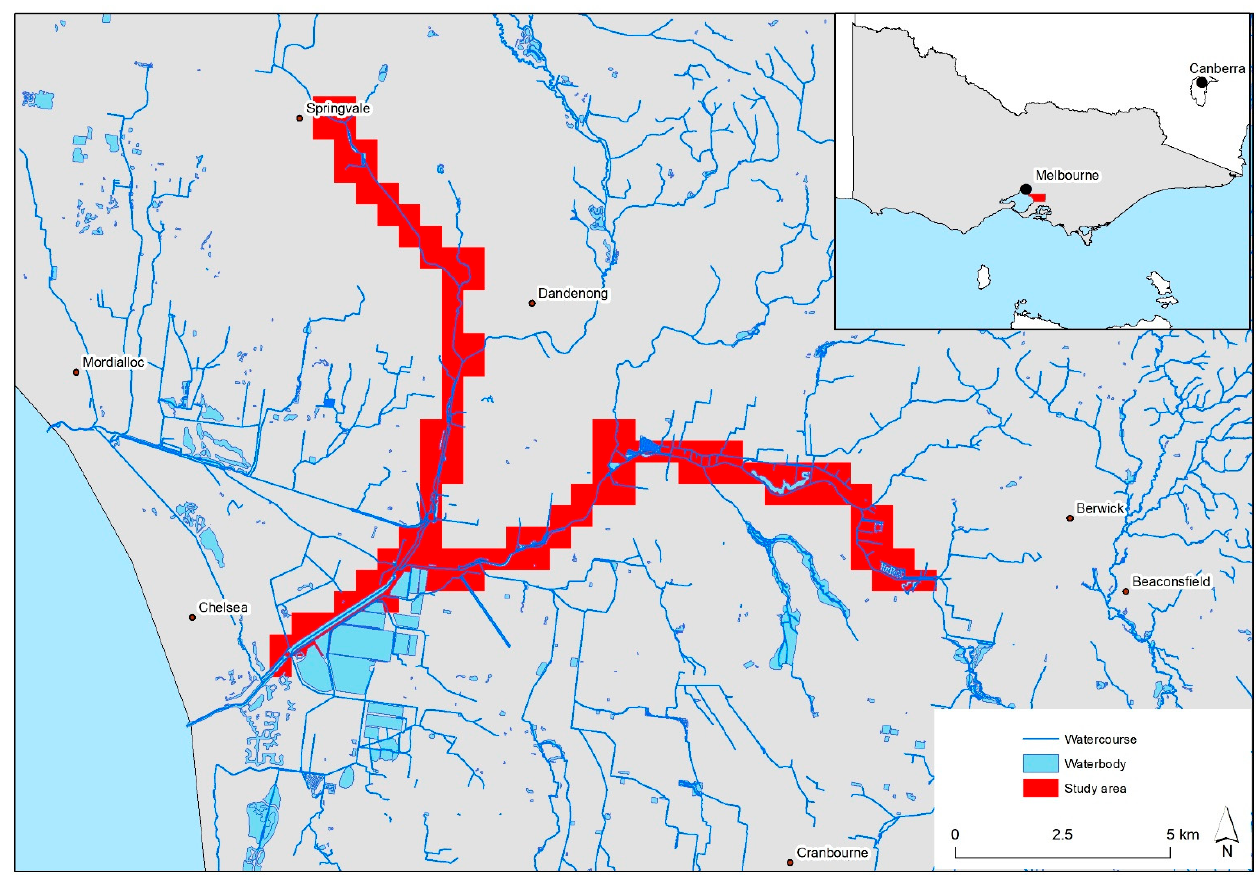
Figure 1. Study area located in eastern Melbourne (37–38°S), Victoria, Australia.